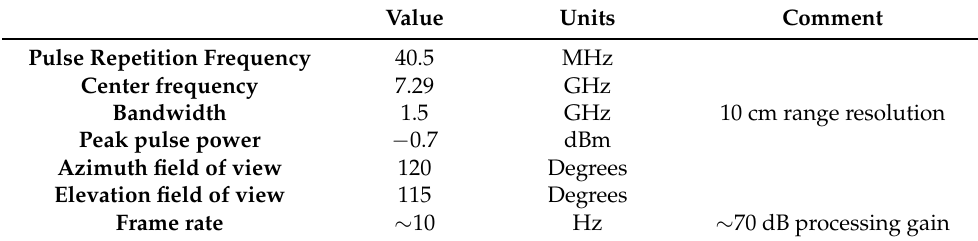
Table 1. Radar parameters.